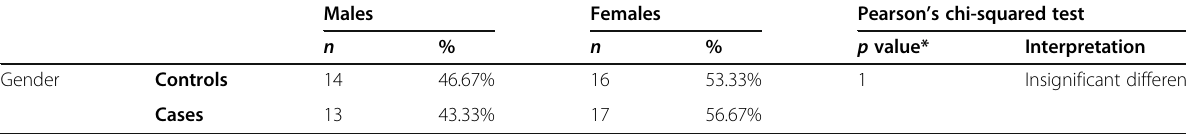
Table 2 Descriptive analysis of gender regarding each group and between-group comparisons